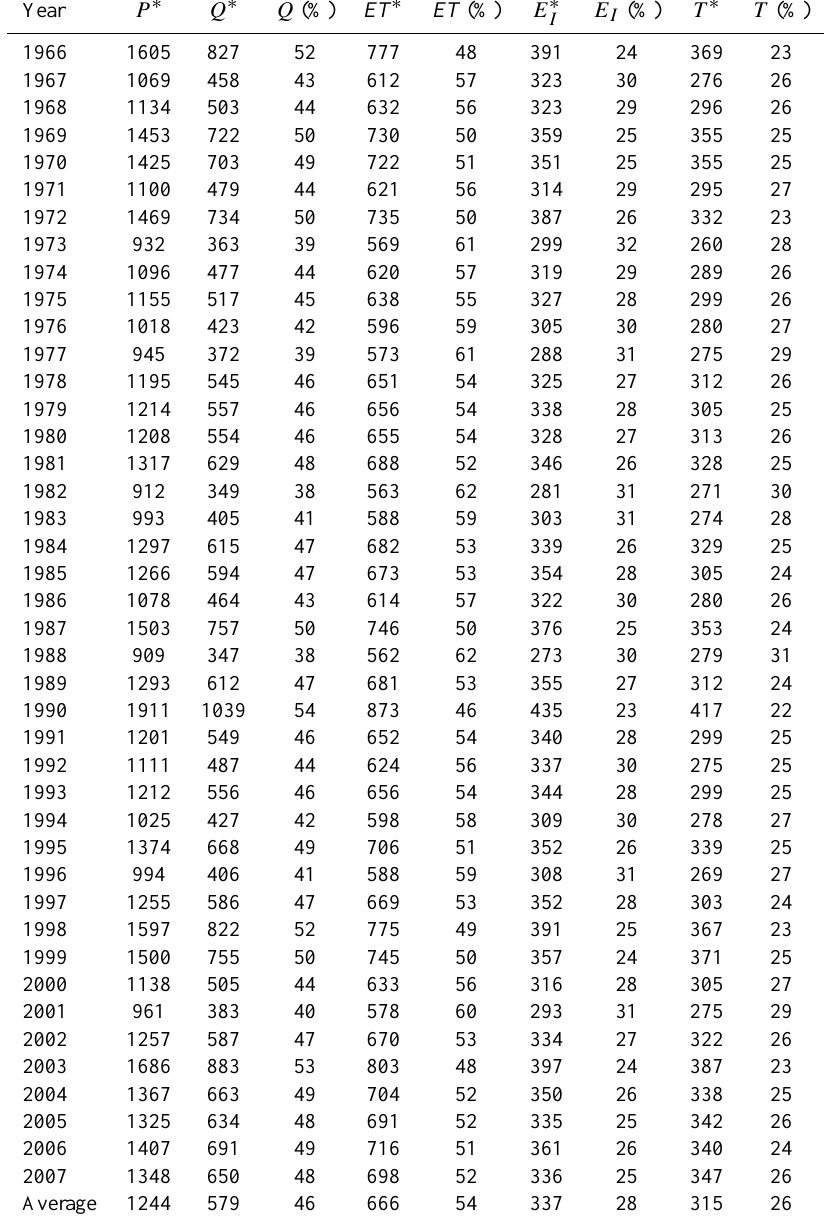
Table 1. Precipitation and estimated water budget components in the Han River basin from 1966 to 2007 ( P : precipitation, Q : discharge, ET : evapotranspiration, E I : evaporation from intercepted rainfall, T : transpiration). Evaporation from soil/water surfaces ( E S ) was not shown in the table, although its amount was included in the water budget calculation. P is from WAMIS database (www.wamis.go.kr) and the rest of water budget was derived by a series of exercise discussed in the